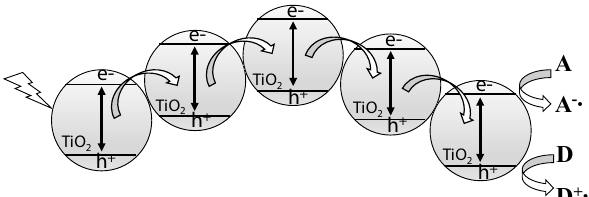
Figure 4. Photocatalytic antenna